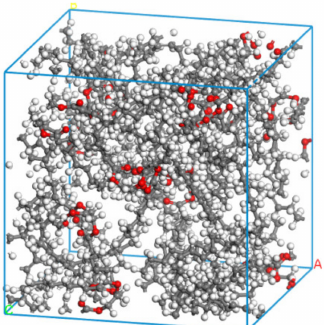
Figure 1. Model of natural ester insulating oil.